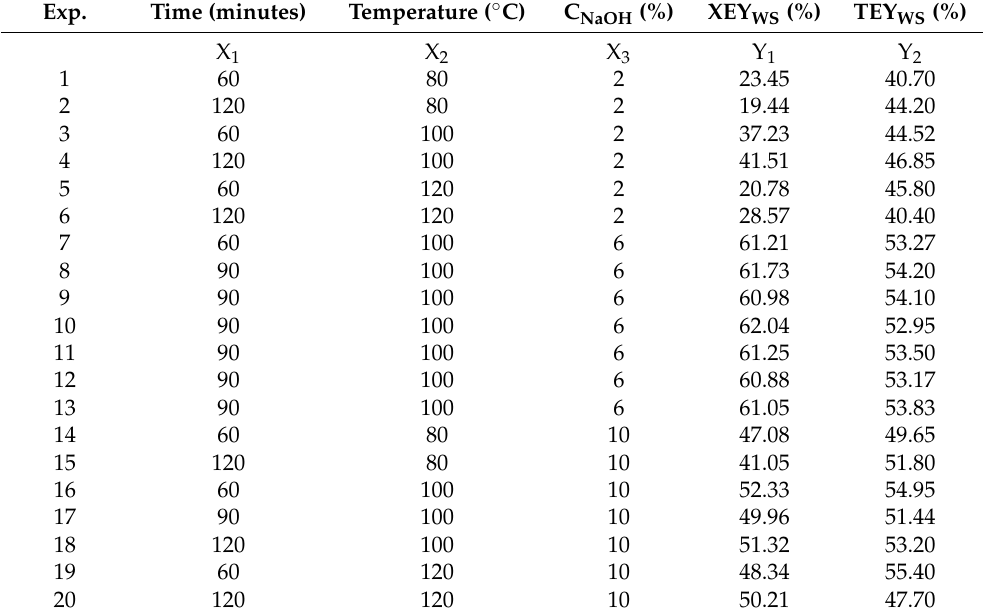
Table 3. Xylan and total extraction yield results for WS HAE. Exp.